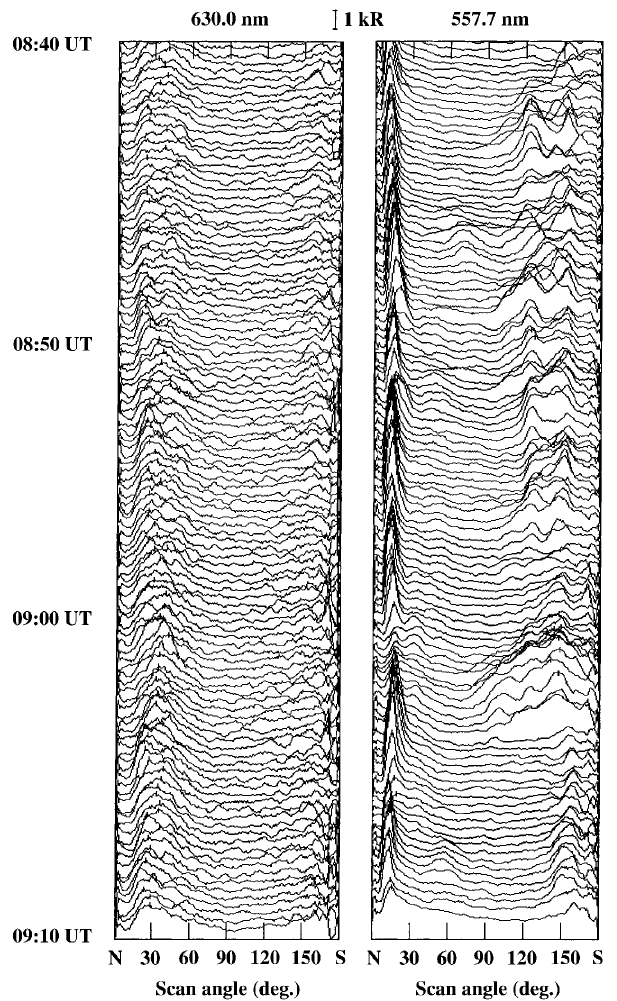
Fig. 4. Intensities of the 557.7 nm ( right panel ) and 630.0 nm ( left panel ) emissions observed by the MSP at Longyearbyen from 0840 to 0910 UT as a function of elevation measured from the